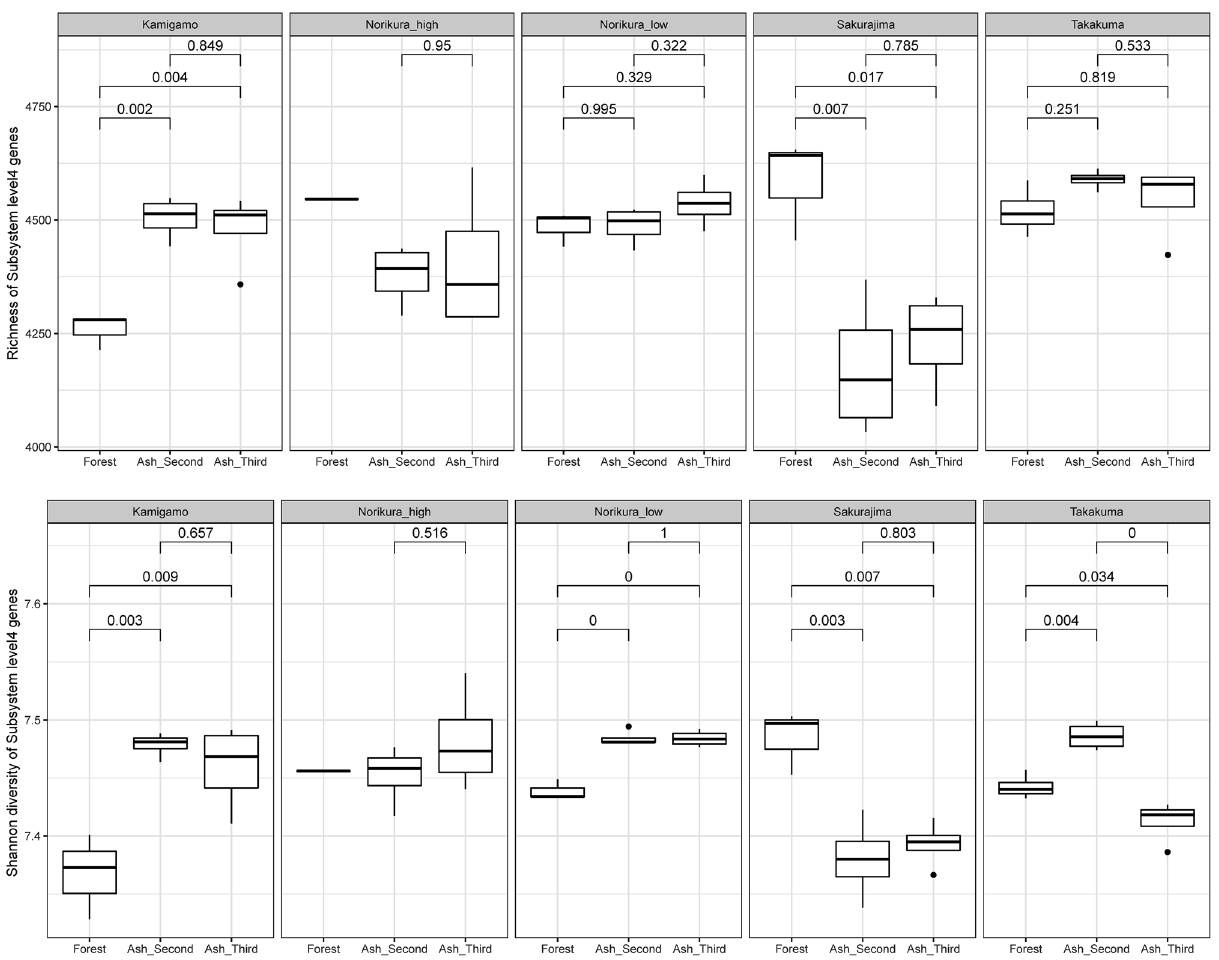
Figure 8. Box plots showing richness of Subsystem level 4 functional genes (upper) and Shannon diversity of Subsystem level 4 functional genes